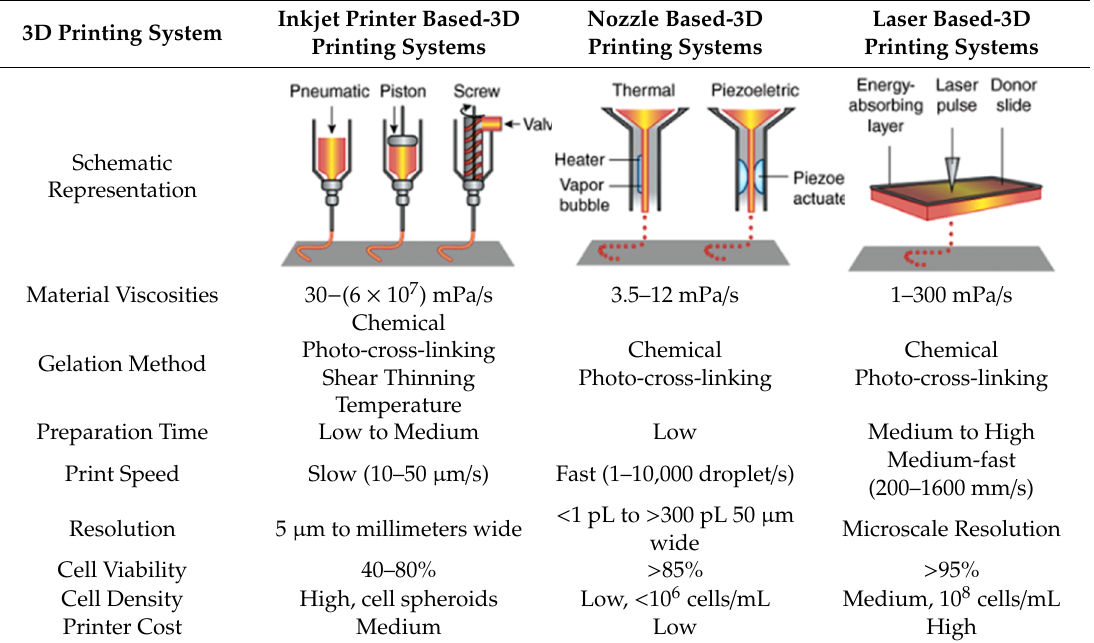
Table 2. Three type of 3D printing hydrogel processing and its limitations [120].